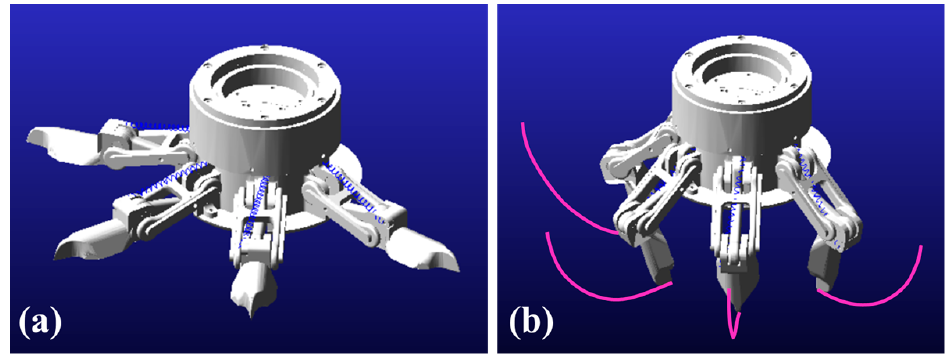
Figure 10. Grasping behavior simulation: ( a ) retrieving state and ( b ) grasping state.